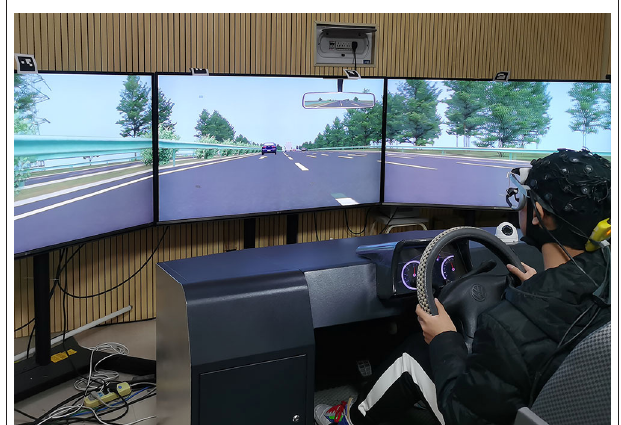
FIGURE 1 | Experimental